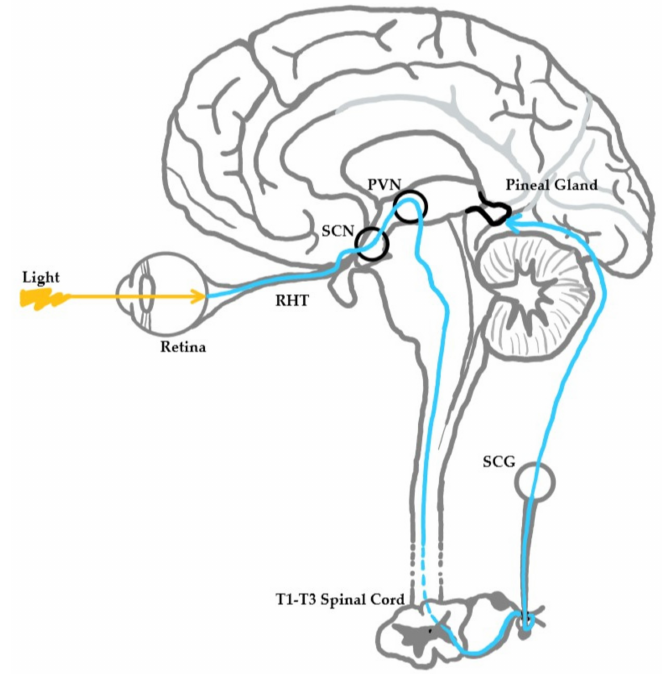
Figure 2. Neuroanatomical pathway of light stimulus to the pineal gland. Light strikes the retina, which results in a neuronal signaling cascade from retina to retinohypothalamic tract (RHT) to suprachiasmatic nucleus (SCN) to paraventricular nucleus (PVN) to the brainstem to the spinal cord (levels T1-T3) to the superior cervical ganglion (SCG) to the pineal